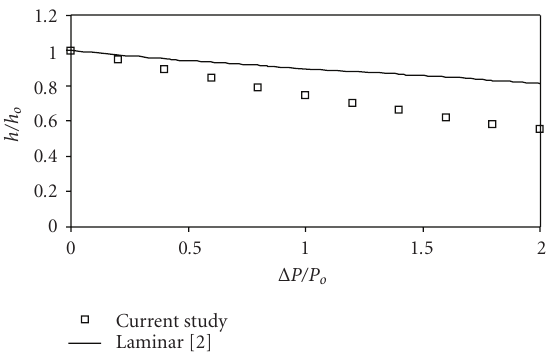
Figure 7: Elastic wall deflection with increasing Δ P for a h o = 1 . 2mm case. (Normalization constants: P o = 100Pa and h o = initial constriction height.)